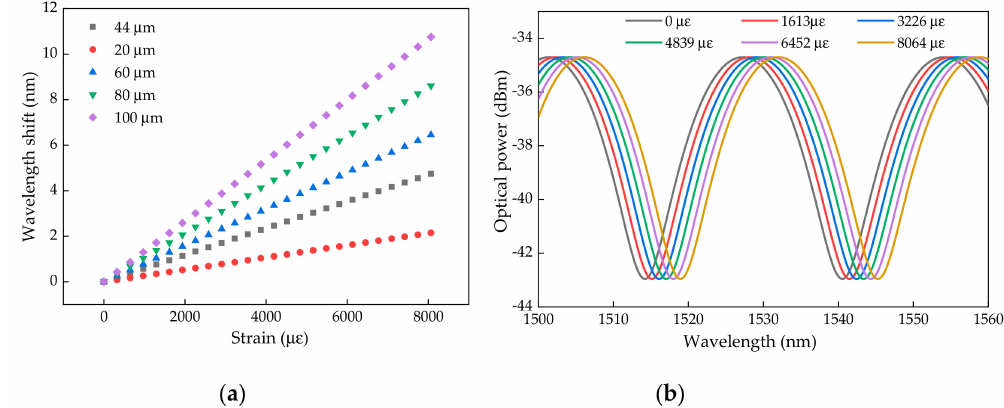
Figure 5. ( a ) Simulated dependency of the wavelength shift according to the applied strain for di ff erent cavity lengths (Equation (6)); ( b ) Simulated spectral function shift induced by di ff erent applied longitudinal elongations for a micro-cavity with a length of 44.07 µ m (Equation